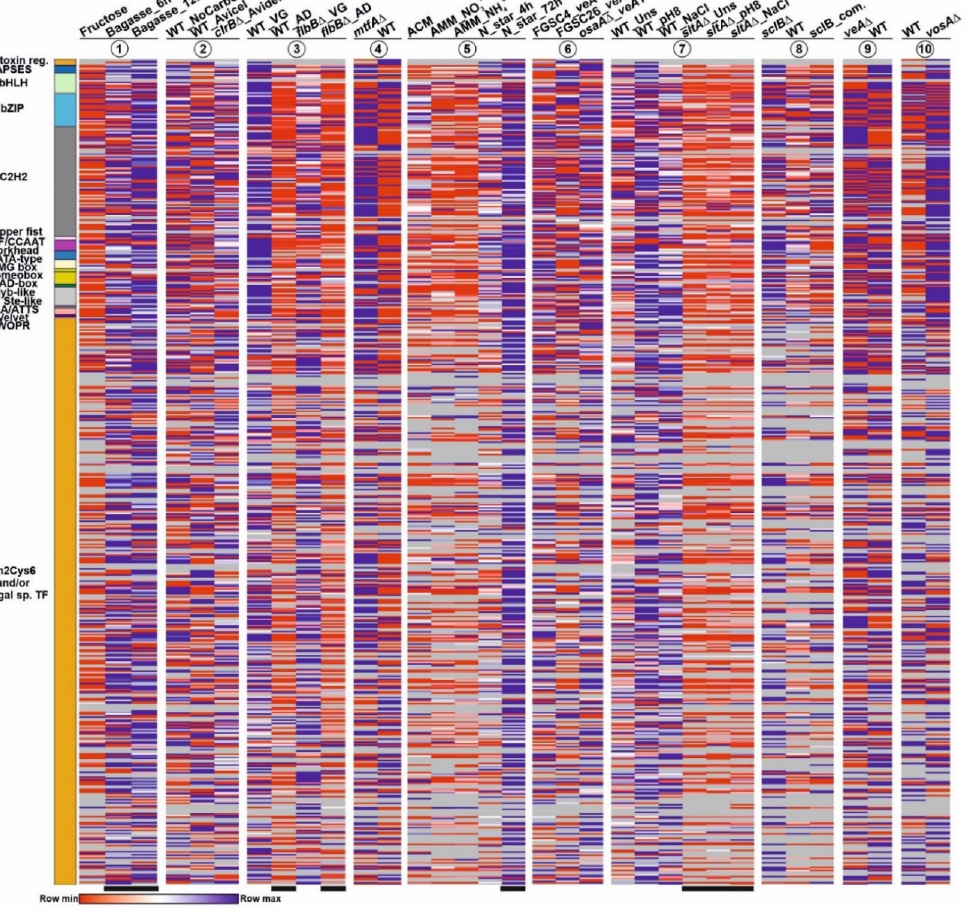
Figure 3. Expression pattern of each TF-coding gene of each IPD family under different culture conditions and in genetic backgrounds. Heatmaps were not clustered, so as to observe if there could be any general expression pattern associated to a specific family of IPDs. Colors in the left bar indicate each IPD family and follow the same color key as in the previous figures and tables. The extension of each color bar reflects the predicted number of genes within each family of IPDs (each row in the heatmaps). Heatmaps 1 to 10 show variation of expression (1) with the use of sugarcane bagasse (FPKM values), (2) in a null clrB mutant (FPKM), (3) a null flbB mutant (FPKM) before (VG) and after (AD) the induction of conidiation, (4) a null mtfA background (FPKM), (5) nitrogen starvation (FPKM; see main text), (6) a null osaA background (FPKM), (7) a null sltA background (under standard culture conditions, pH 8, or addition of 1M NaCl) (TPM), (8) a null sclB background (TPM), (9) a null veA background (FPKM) and (10) a null vosA background (FPKM). See references in the Materials and Methods section. All FPKM/TPM values below 5 were removed from the heatmaps and are indicated in gray, in order to highlight those TF-coding genes showing low or null expression levels in most or all genetic backgrounds and culture conditions. Black bars below the heatmaps indicate genetic backgrounds and culture conditions in which a change in the general expression pattern of the A. nidulans TFome might be induced. See also Figure S1 and Table